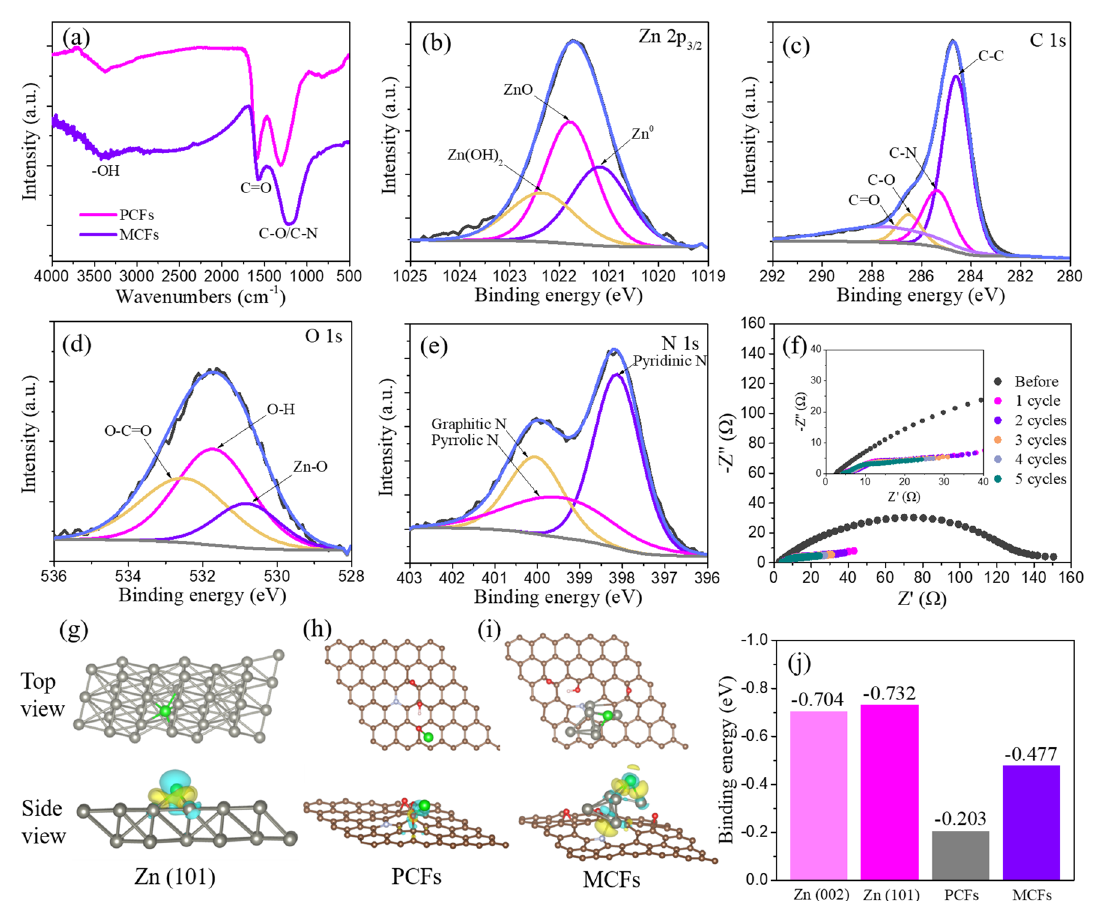
Fig. 4 a FTIR spectra of PCFs and MCFs. b–e XPS spectra of Zn 2 p 3/2 , C 1 s , O 1 s and N 1 s for MCFs, respectively. f Electrochemical imped‑ ances spectra of Zn@MCFs symmetrical cell before and after 1, 2, 3, 4, 5 cycles. g–i Surface atomic configuration models of zinc onto Zn (101), PCFs and MCFs and corresponding electron cloud distributions, respectively. j The calculated binding energy comparison of Zn onto different